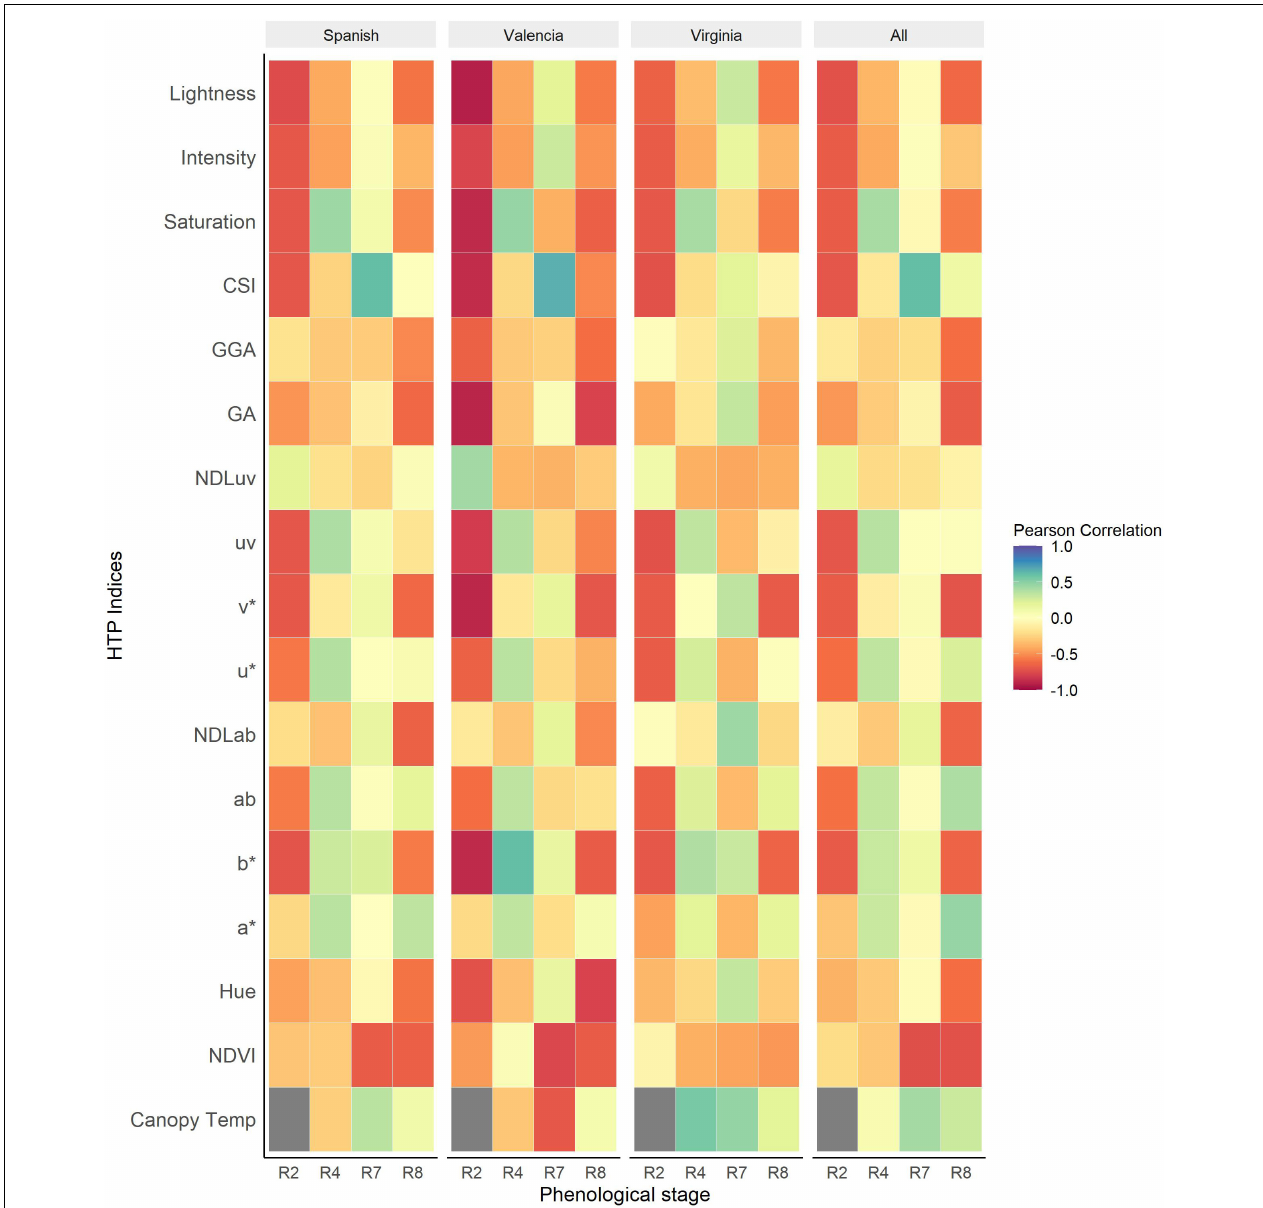
FIGURE 5 | Heatmap of Pearson correlations between HTP derived indices and visual scores of Groundnut rosette disease (GRD) at different phenological stages of the growing season for the individual market types and all the market types analyzed together. The dark gray boxes represent missing data.